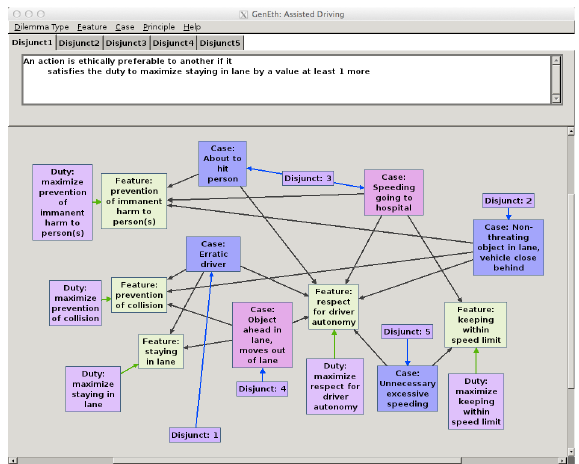
Figure 4 GenEth’s principle display which shows a natural language version each disjunct in a tabbed format as well as a graph of the relationships between these disjuncts and the input cases they cover along with their relevant features.